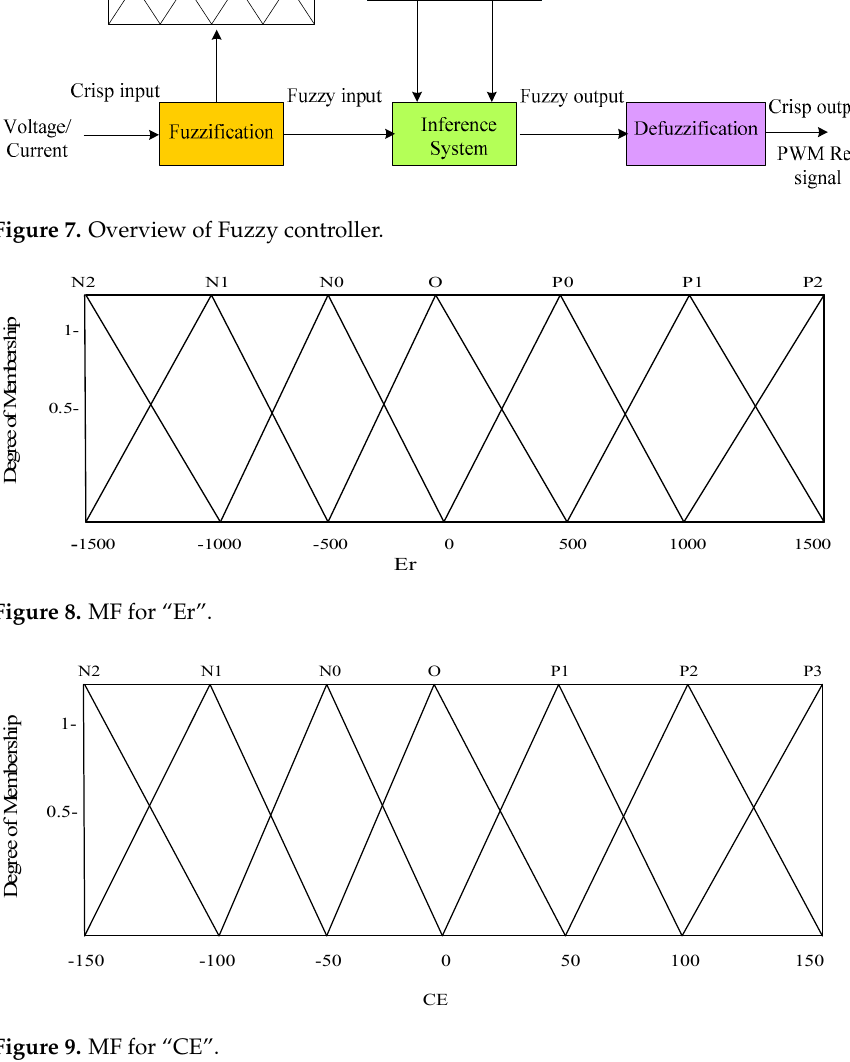
Figure 9. MF for “CE”. Table 4. MF mapping for capacitor voltage.